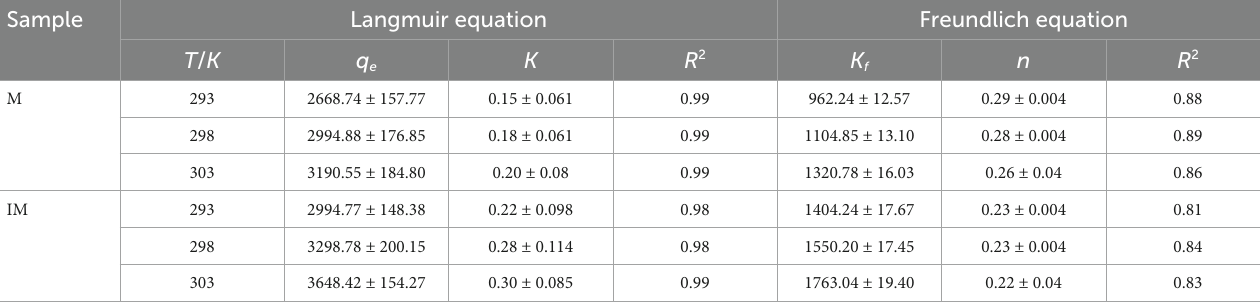
TABLE 4 Atrazine adsorption parameters of the isotherms on carrier materials (M) and immobilized carrier materials (IM) described by the Freundlich and Langmuir equations.